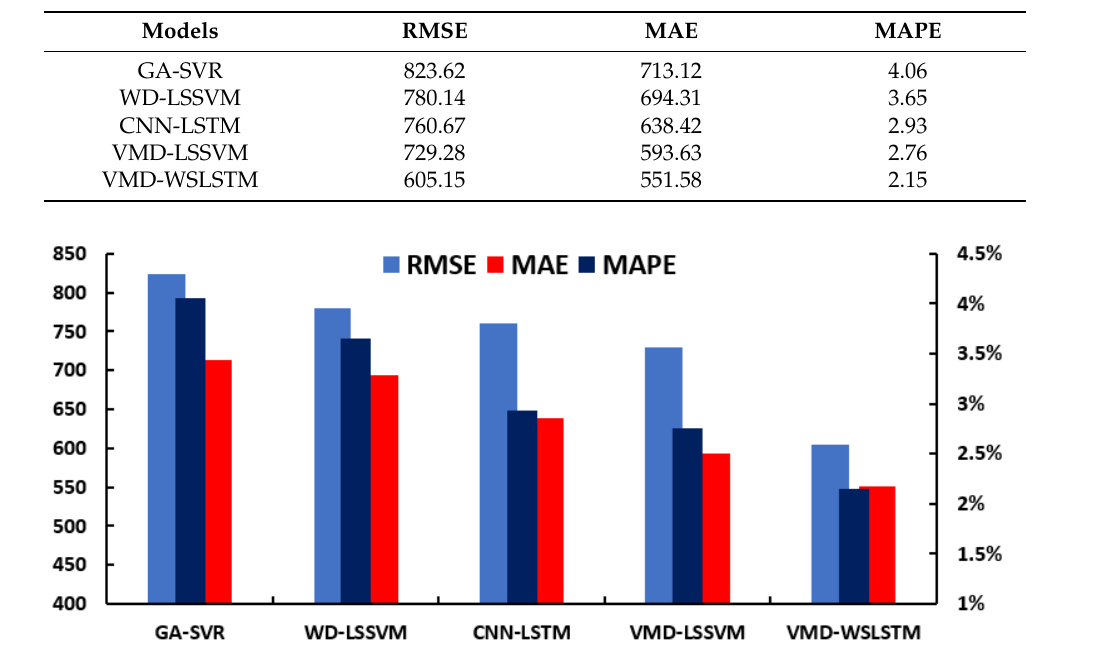
Table 9. Prediction results of different prediction models.